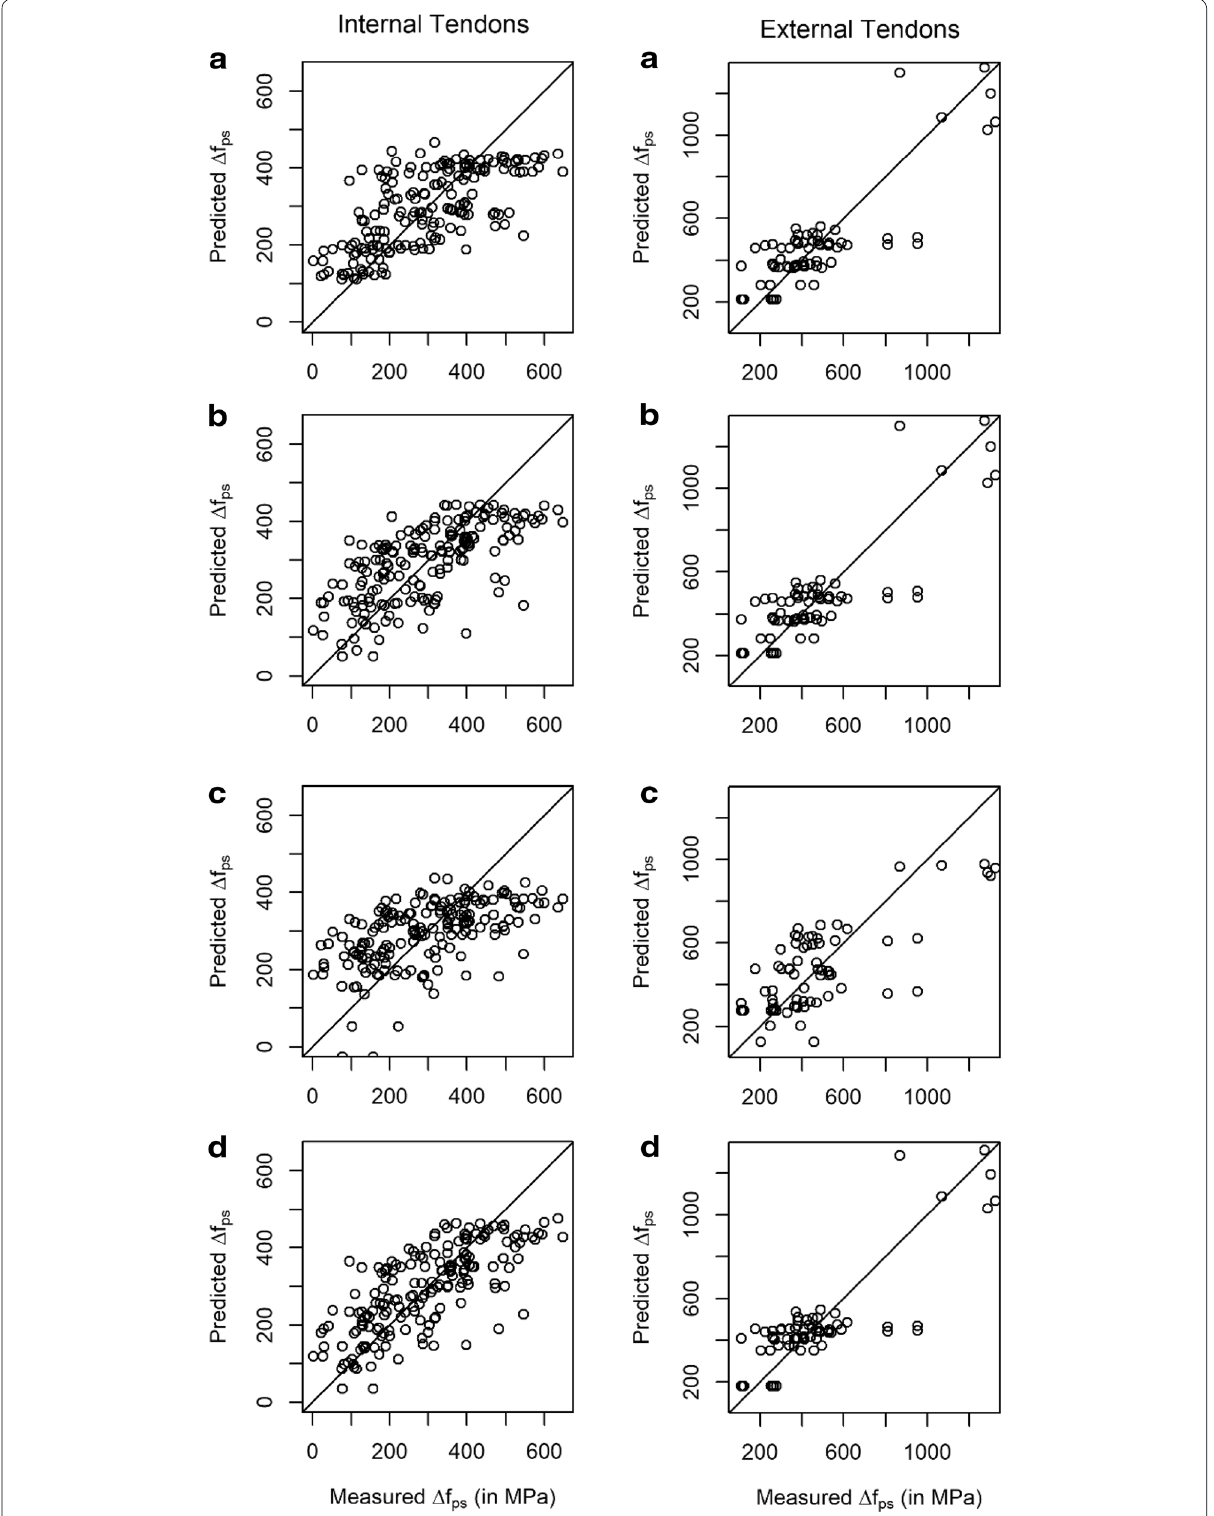
Fig. 5 Measured (cid:31) f ps vs. predicted (cid:31) f ps (in MPa) from the SPCA models using a all variables, and the b combined Continuous and Categorical, c Self-Selected, and d Correlation Cutoff variable